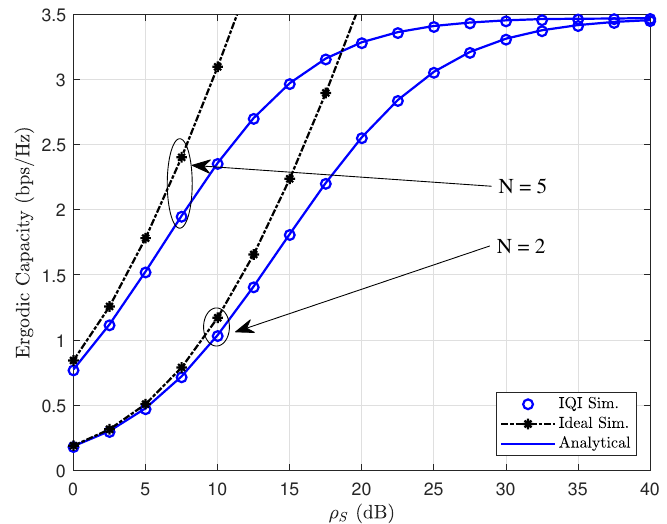
Figure 9. The ergodic capacity vs. ρ S (dB) for RIS-T